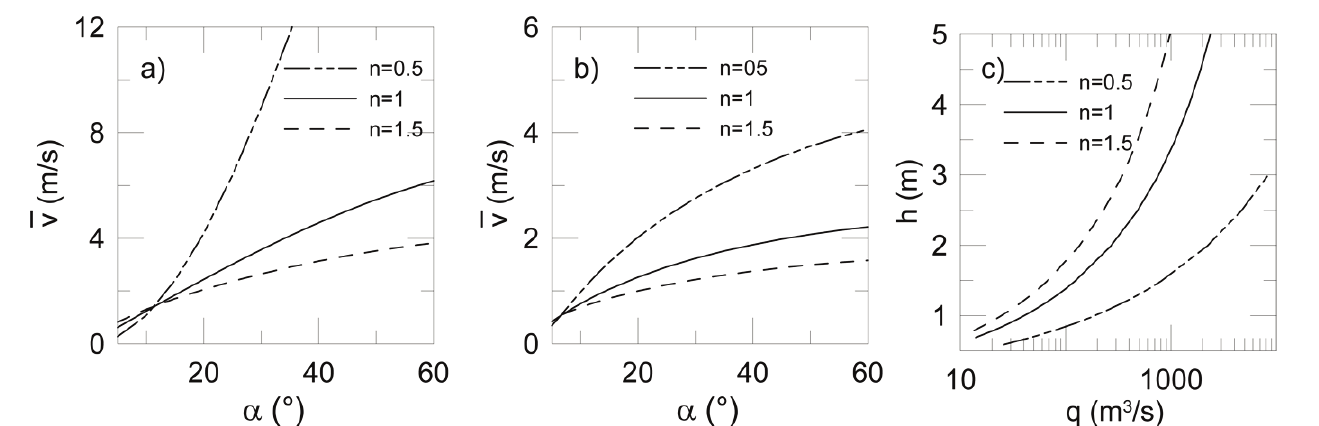
Figure 2. a) Average velocity with respect to a for a fixed geometry ( a = 10 m, h = 4 m, t (cid:0)= 2650 kg m −3 , k = 10 4 Pa s n ); b) Average velocity with respect to a for a fixed q ( a = 10 m, q = 500 m 3 s −1 , t = 2650 kg m −3 , k = 10 4 Pa s n ); c): Thickness h with respect to q ( a = 10 m, a = 20˚, t = 2650 kg m −3 , k = 10 4 Pa s n